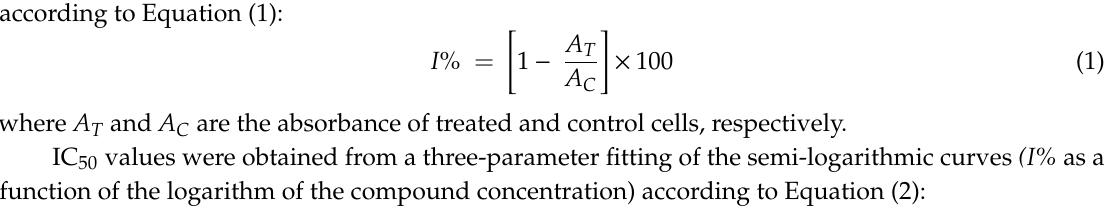
Supplementary Materials: The supplementary materials are available online. Figure S1: 1H NMR spectrum of complex III, Figure S2: 1H NMR spectrum of complex IV, Figure S3: 1H NMR spectrum of complex V, Figure S4: The 1H-1H COSY of complex IV, Figure S5: Mass spectrum of complex III, Figure S6: Mass spectrum of complex IV, Figure S7: Mass spectrum of complex